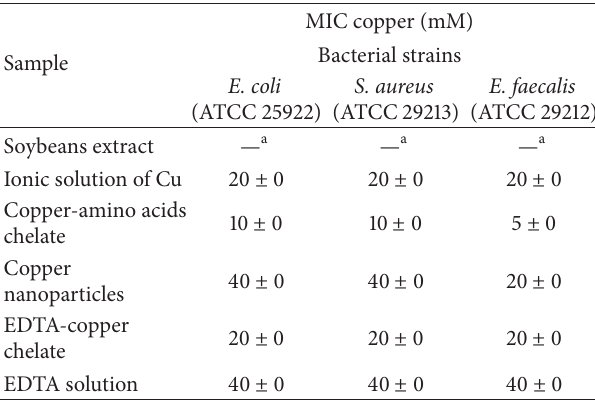
Table 1: Minimum inhibitory concentrations